Question: How would you classify this visualization?
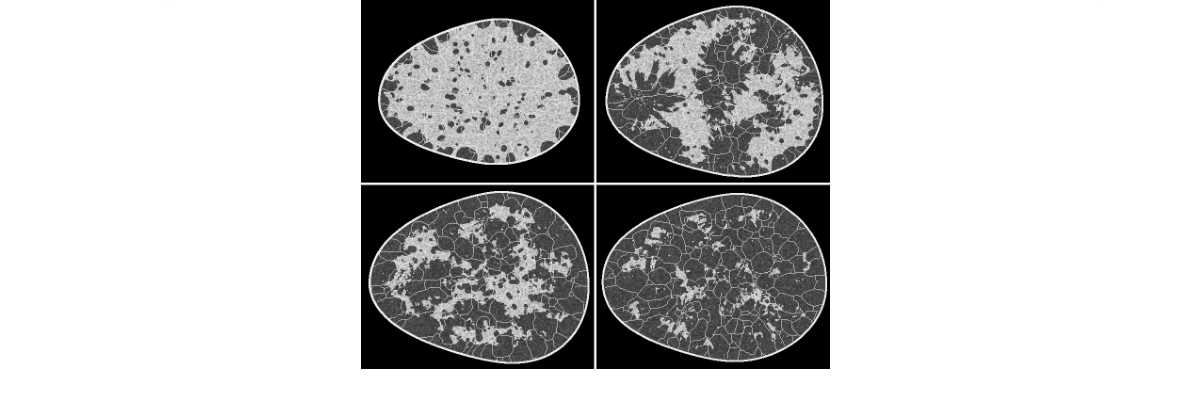
Answer: scatter